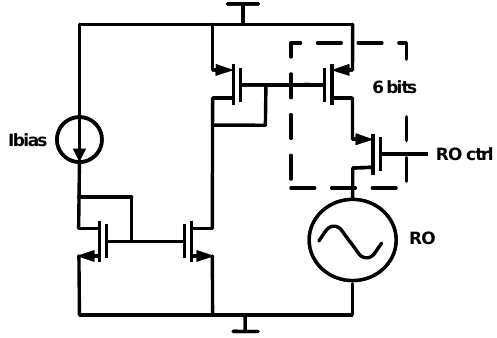
Figure 12. Circuit of the current steering